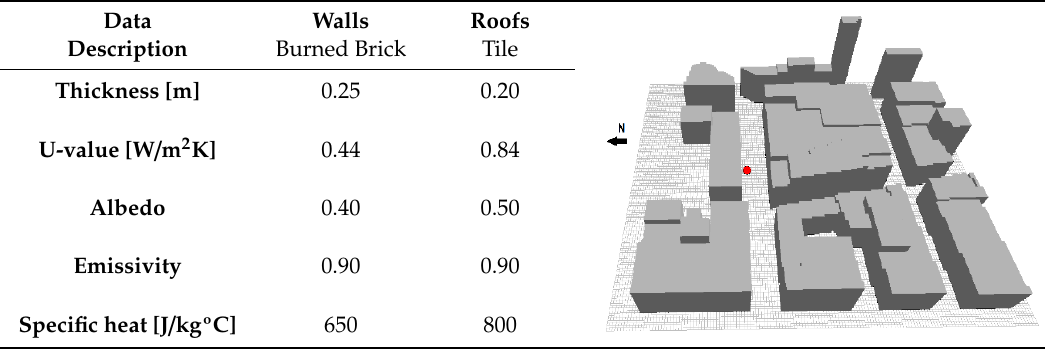
Figure 1. Hourly evolution of air temperature and relative humidity (forcing conditions for the model), measured at the Deusto station. Each day W S and W D was considered constant, and the median value of the hourly data between 10:00 and 20:00 (UTC) was used as input to the model. Between these hours air flow characteristics registered in Deusto (i.e., 30 m a.g.l.) were quite similar and corresponded to a well-established sea breeze. W S was adjusted to 10 m a.g.l. using the power law for wind profile [88,89]: (cid:1849) (cid:3020)(cid:2869)(cid:2868) = (cid:1849) (cid:3020) (10 ℎ⁄ ) ∝ where W S is the wind speed (ms −1 ) at the height of h and α is an empirical exponent which depends on the surface roughness. In this case α = 1/7 because the measurements were done in an open terrain with obstacles not closer than 75 m. The estimation of solar radiation made by the model was adjusted by comparing with data measured at the Deusto station. The solar factor selected to adjust the shortwave solar radiation simulated by the model for each modelling period (i.e., each day) was